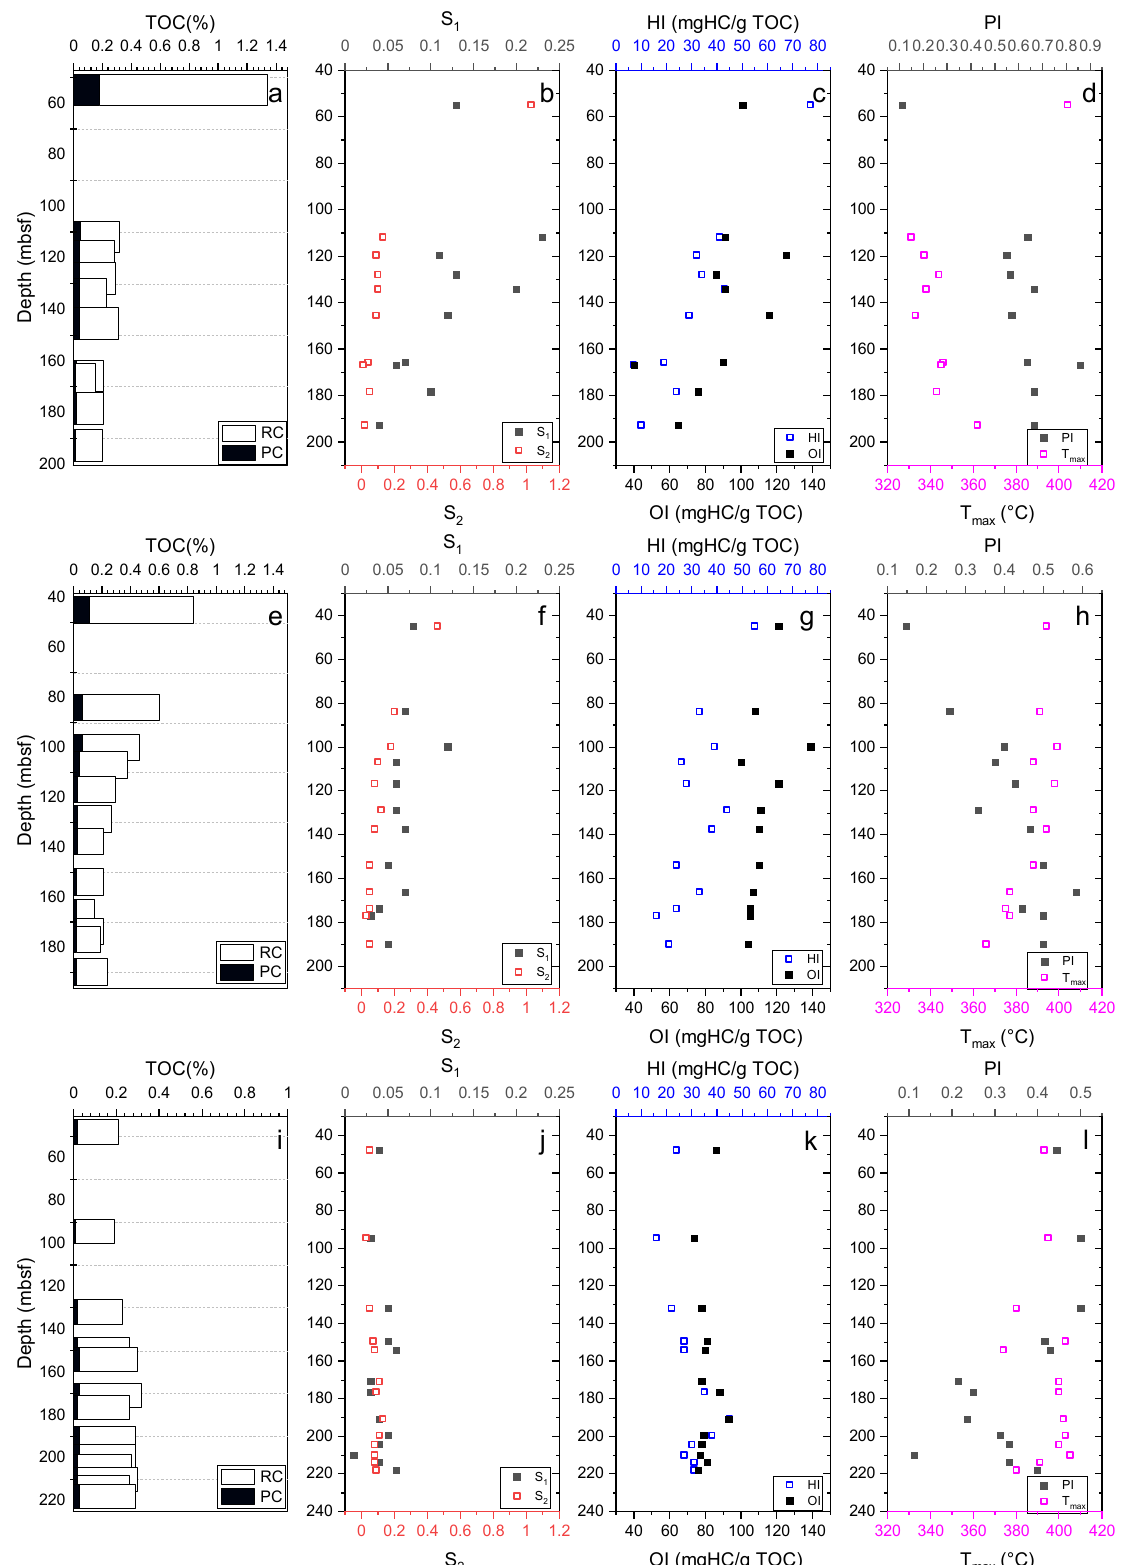
Figure 3. Depth profile of total organic carbon (TOC) (including pyrolysable organic carbon (PC) and residual organic carbon (RC)), free hydrocarbons (S 1 ), oil potential (S 2 ), hydrogen index (HI), oxygen index (OI), production index (PI), and T max of W01B ( a – d ), W02B ( e – h ), and W03B ( i – l